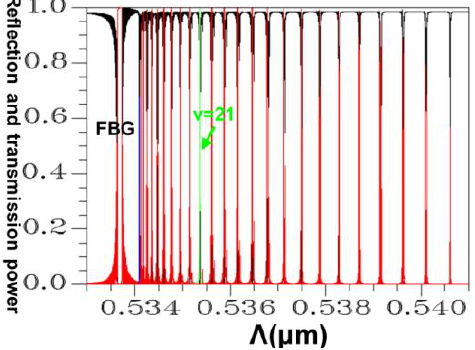
Figure 25. An optical spectra plot for the total coupling from HE cladding mode ( ν = 21). The black line expresses the core mode and cladding modes transmission power. The red line expresses the core mode and cladding modes reflection